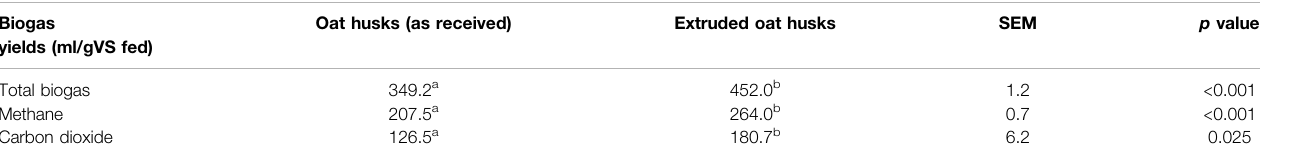
TABLE3| TheeffectoftheBioExtruderpre-treatmenttechnologyonthemeantotalbiogas,methaneandcarbondioxideyields(ml/gVSfed)fromoathusks,minustheblank assay biogas yields. Biogas Oat husks (as received) yields (ml/gVS fed)